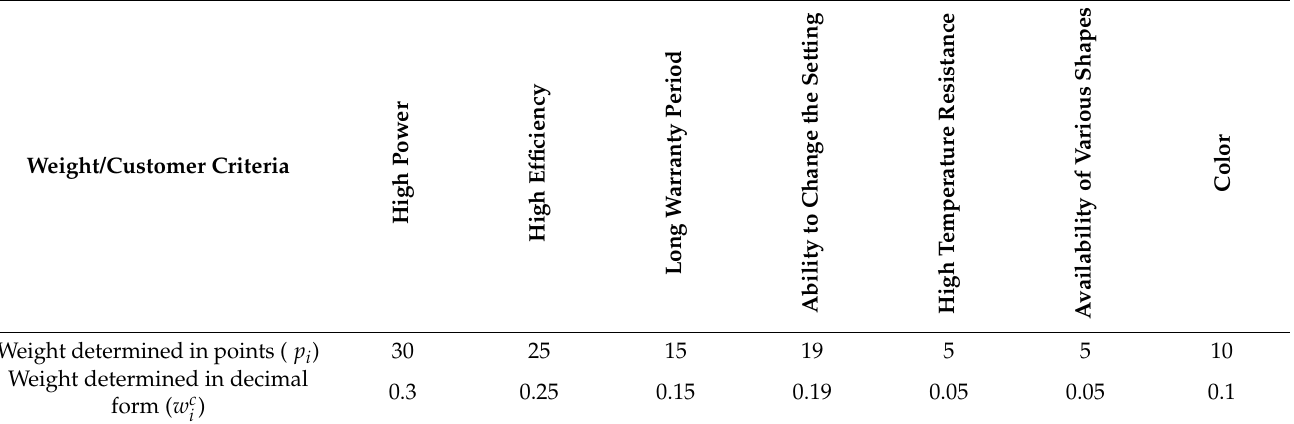
Table 3. Weights of criteria of photovoltaic panels determined by customer.